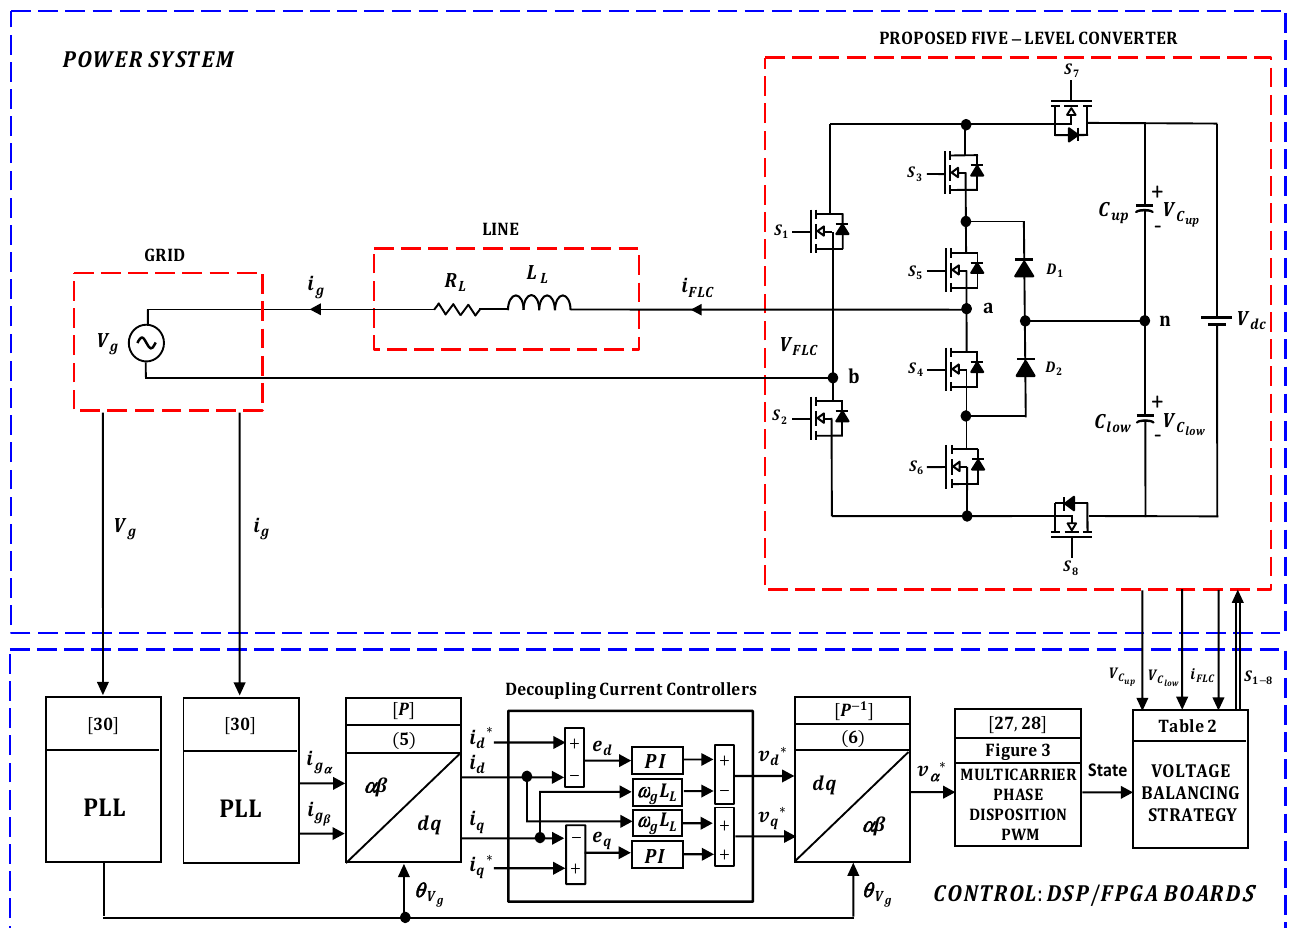
Figure 4. Block diagram of the proposed grid-tied SPFLC and its current vector control in the 𝑑𝑞 rotating coordinates.